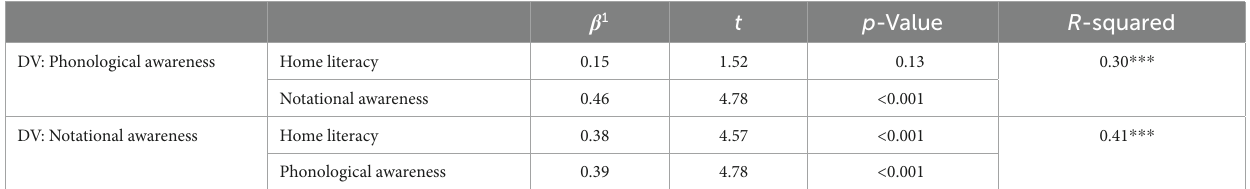
TABLE 3 Multiple linear regression analyses.